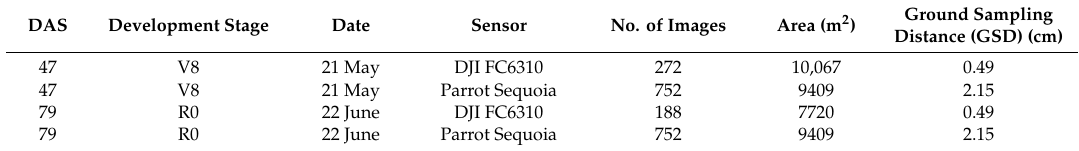
Table 1. Flight log, sensors, and orthomosaics on di ff erent days after sowing (DAS).